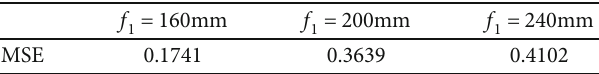
Figure 3: SLM simulation of reproduced images loaded with di ff erent mask focal lengths. Table 2: Comparison of reconstruction errors for di ff erent mask focal